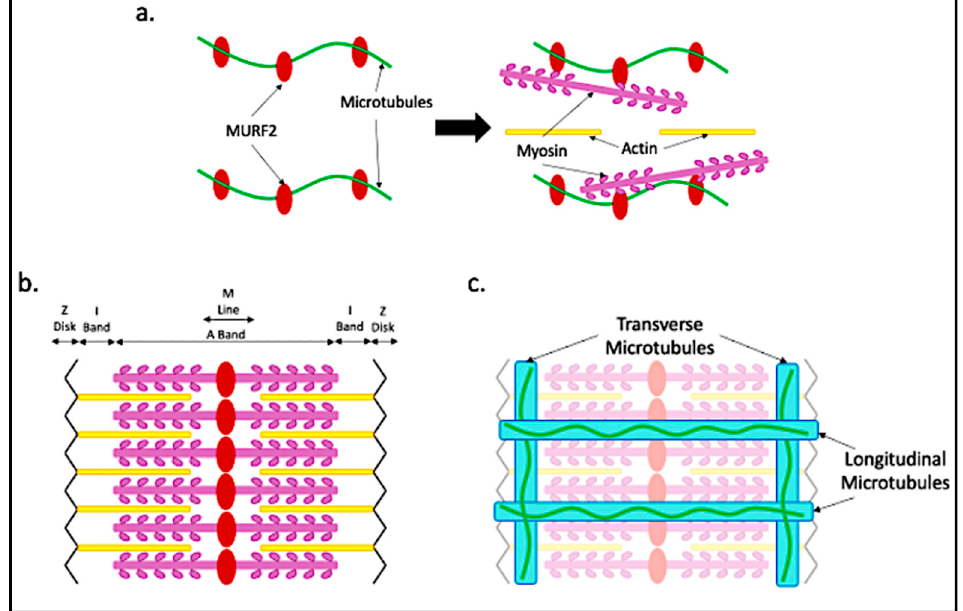
Figure 4. Microtubule alignment with respect to the sarcomere. ( a ) During sarcomere assembly, microtubules bound by MURF2 provide scaffolding for myosin trafficking and binding to generate the A-band; ( b ) the sarcomere takes shape after myosin is in place and actin aligns; ( c ) dystrophin aligning with the I-band allows for transverse microtubule binding. Dystrophin running longitudinally provides scaffolding for the longitudinal microtubules.